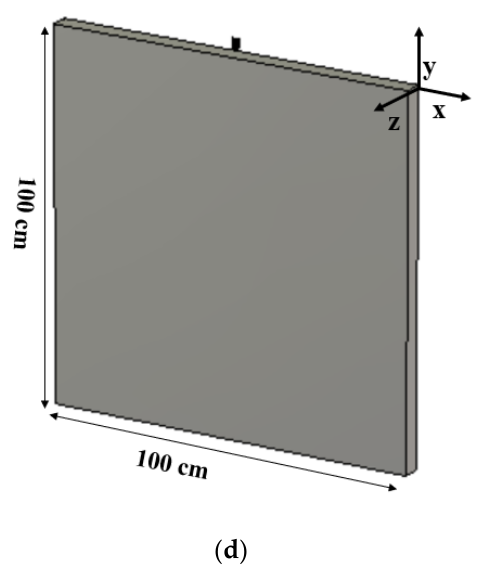
Figure 18. Housing effect of the antenna: ( a ) 40 cm × 40 cm, case-1, ( b ) 40 cm × 40 cm, case-2, ( c ) 1 m × 1 m, case-1, (d) 1 m × 1 m, case-2.